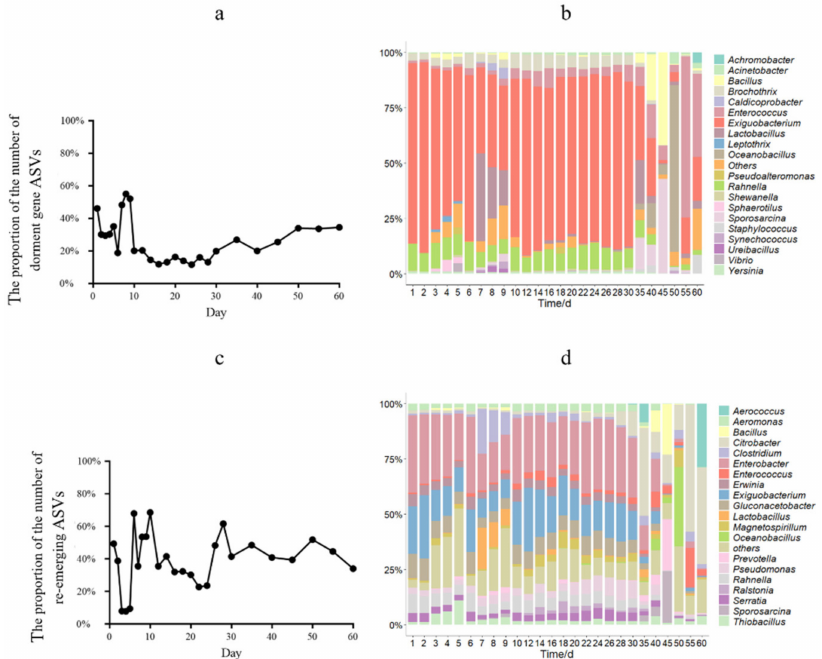
Figure 2. Number and genus of ASVs identified in 60 days. ( a ) Change in the proportion of ASVs identified by GFP; ( b ) genus identified by GFP; ( c ) change in the proportion of ASVs identified by RAM; ( d ) genus identified by